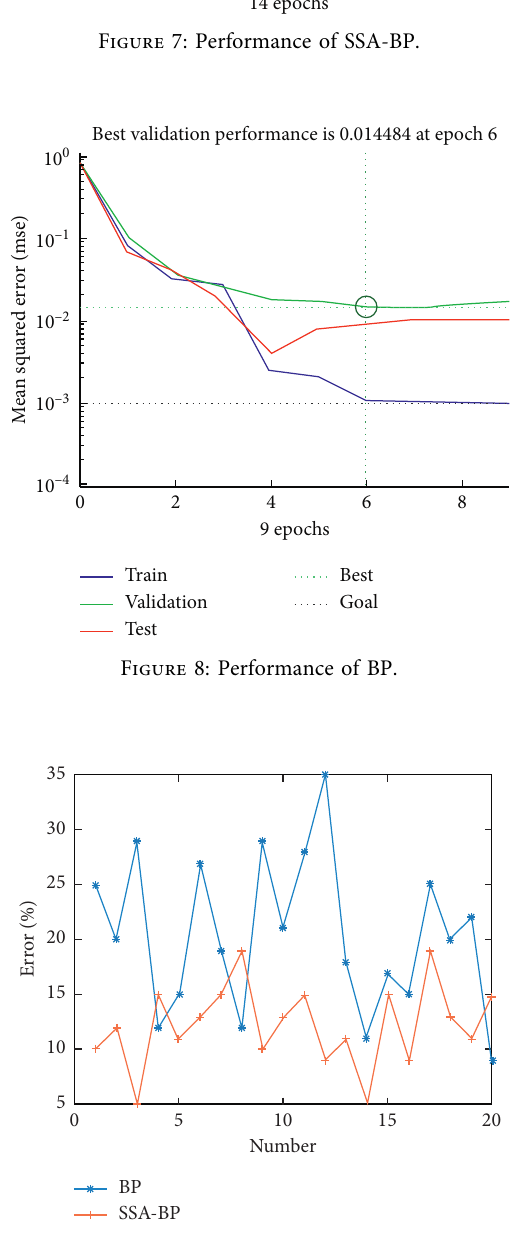
Figure 9: Error comparison of SSA-BP and